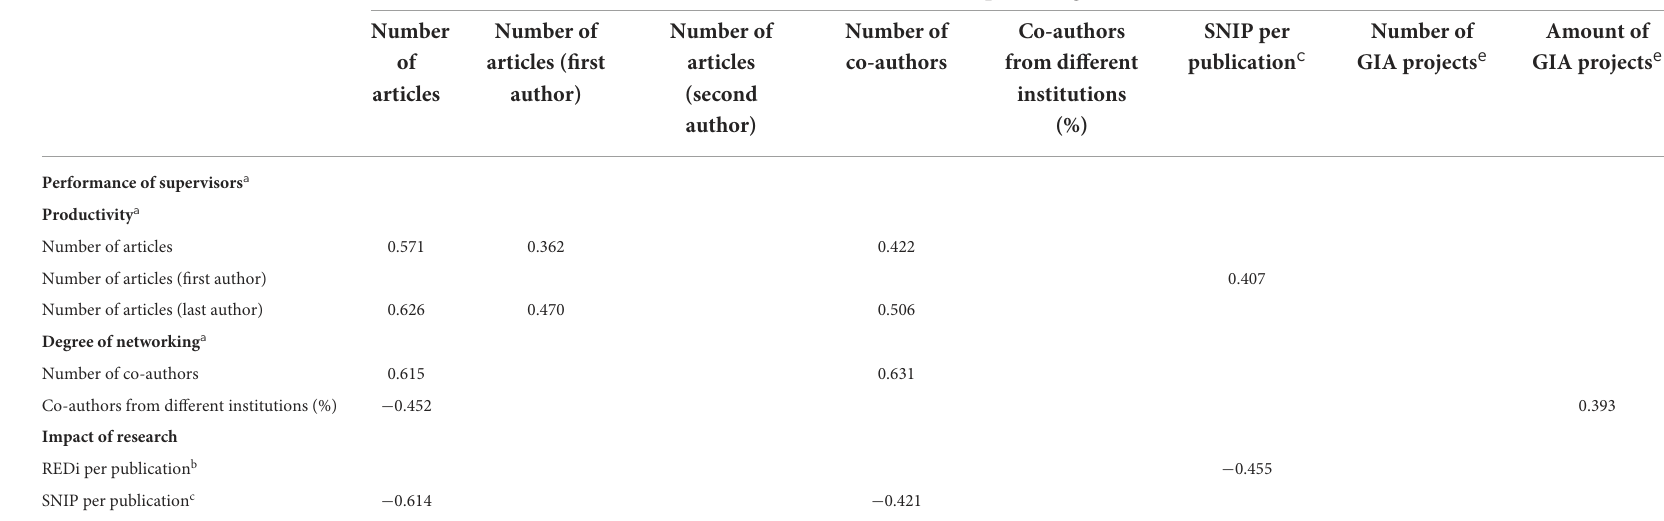
TABLE 3 Diachronic correlation between the performance of promising researchers and their